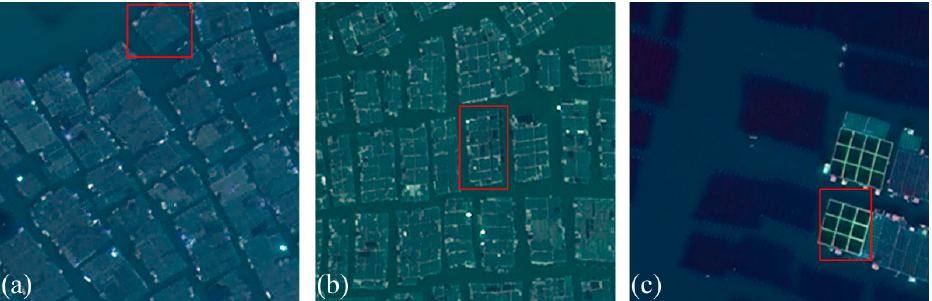
Figure 5. Cage aquaculture areas in GF-1. ( a ) The first type of cage aquaculture (imaged in November 2013). ( b ) The second type of cage aquaculture (imaged in November 2017). ( c ) The third type of cage aquaculture (imaged in April 2020).